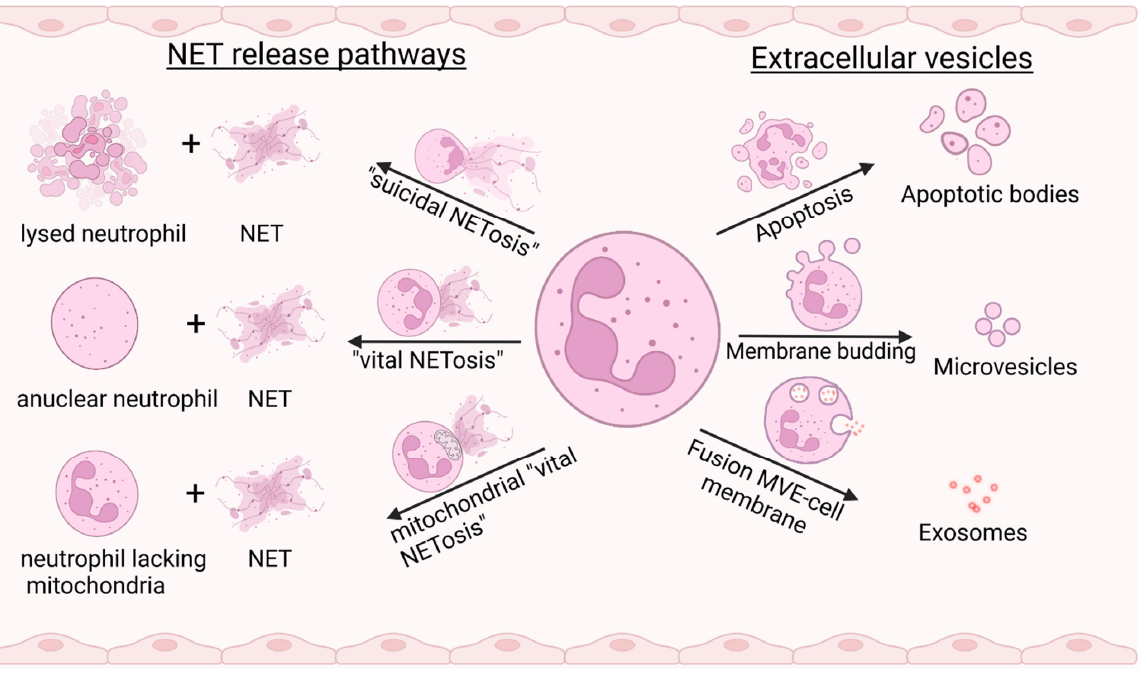
Figure 1. Mechanisms of NET formation ( left ) and EV classes released by neutrophils ( right ). In “suicidal NETosis”, chromatin is released from the lysing neutrophil after chromatin de-condensation and subsequent rupture of the nuclear and cell membrane. “Vital NETosis” is characterized by the fusion of vesicles containing nuclear DNA with the plasma membrane, finally resulting in an anuclear cytoplast. In a second form of “vital NETosis”, neutrophils release mitochondrial DNA by an unknown NOX-dependent mechanism. Extracellular vesicles comprise a group of heterogeneous membranous vesicles of varying size and morphology. Apoptotic bodies represent subcellular fragments after the disassembly of a dying cell. The smaller microvesicles bud from the cell membrane and contain cytoplasmic material. The smallest EVs are referred to as exosomes and are released from the lumen of multivesicular endosomes (MVE), fusing with the cell membrane. Created with